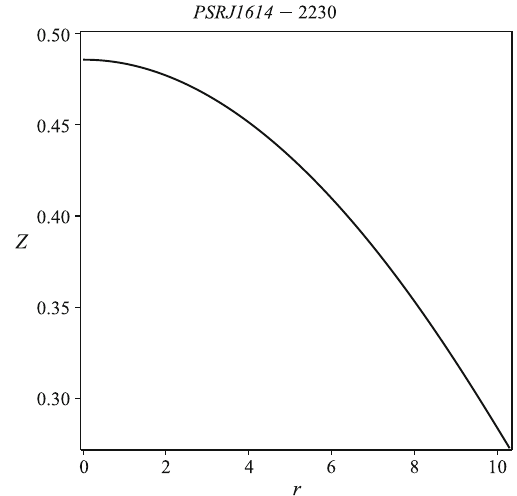
Fig. 11 Variation of gravitational redshift w.r.t. the radial coordinate r for the strange star candidate PSRJ 1614–2230